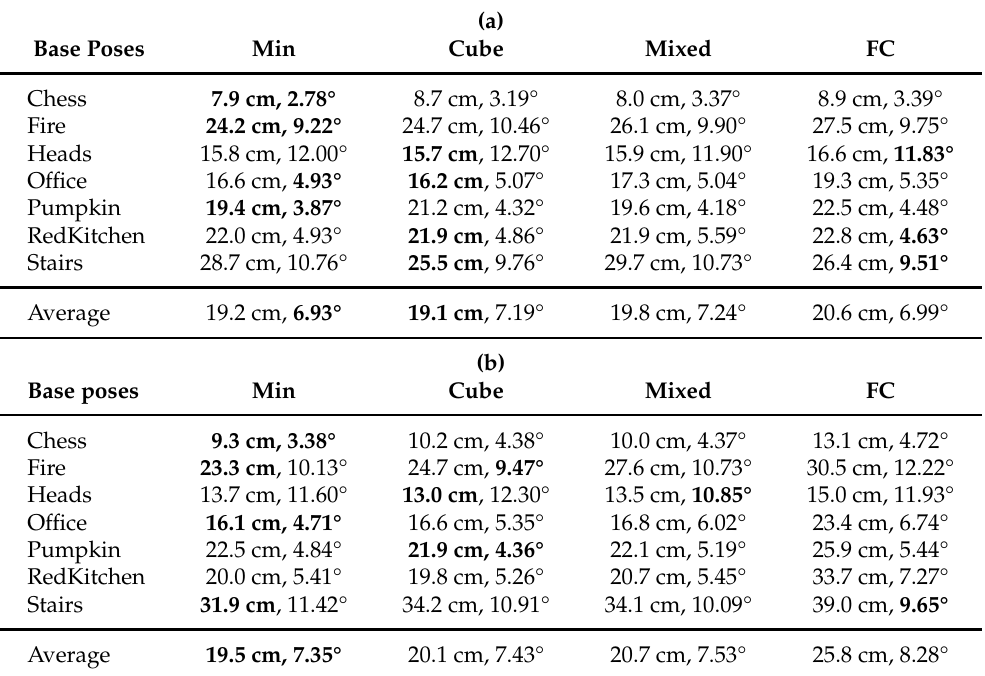
Table 6. Median translation error (cm) and rotation error (°) for single streams with different base poses on 7 Scenes . (a) Color stream; (b) depth stream. Bold numbers indicate the lowest error